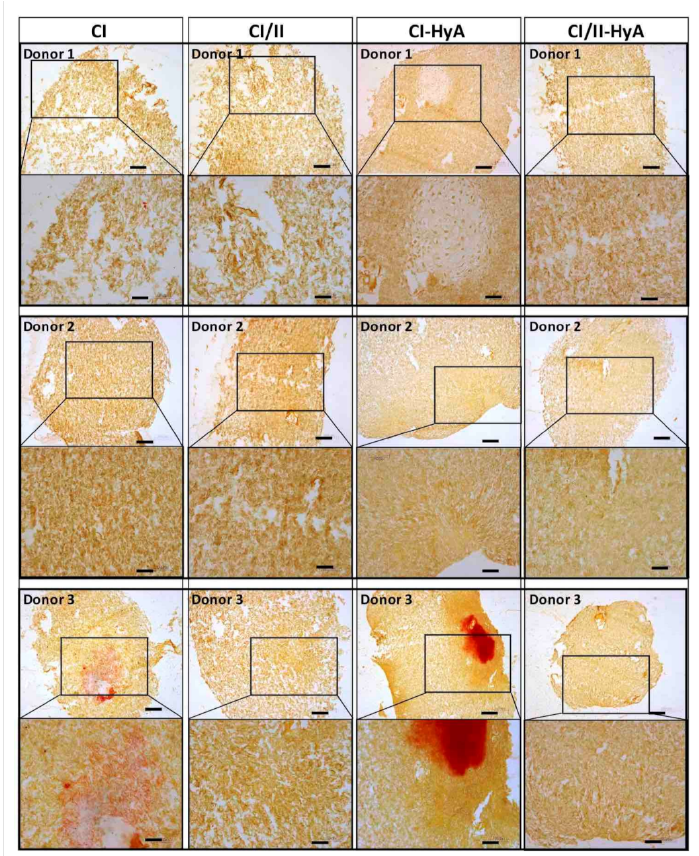
Figure 6. The incorporation of CII did not promote further bone-like tissue formation. Representative histological images of cell-seeded scaffolds stained with alizarin red after 28 days in culture. Scale bar represents 200 µ m length ( top images) and 100 µ m length ( bottom images). The histological images were collected for scaffolds seeded with human MSCs from donors 1, 2 and